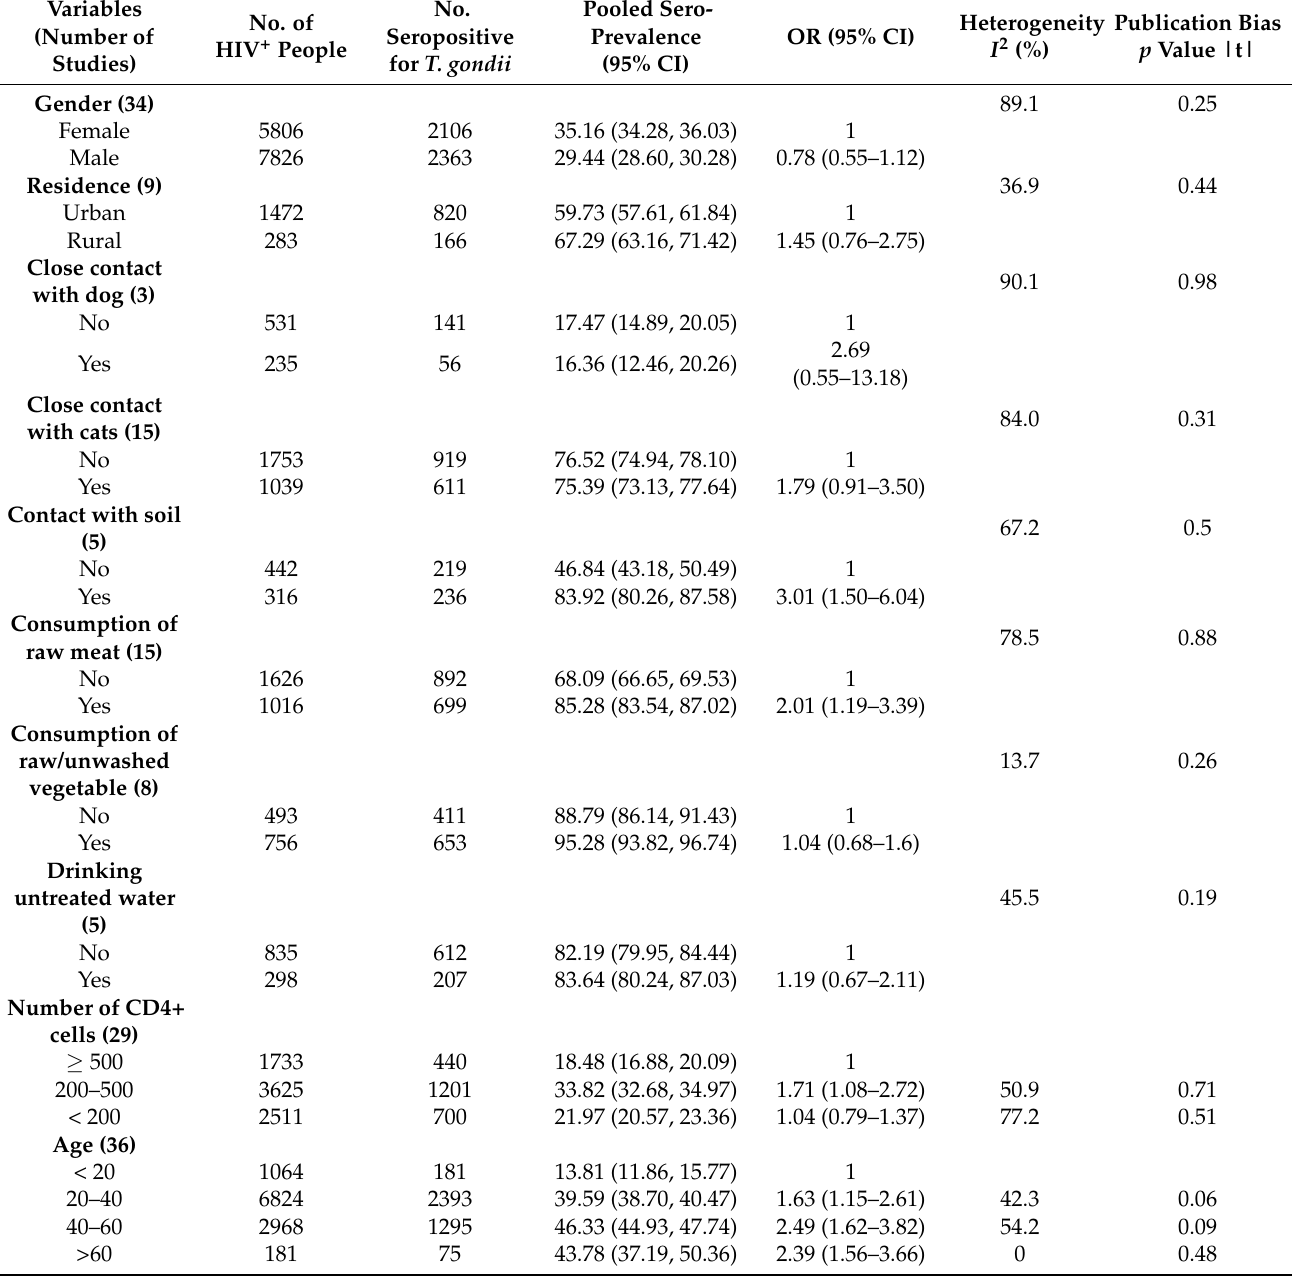
Table 3. Risk factors associated with HIV + people inferred to have Toxoplasma gondii infection based on their serological profile.